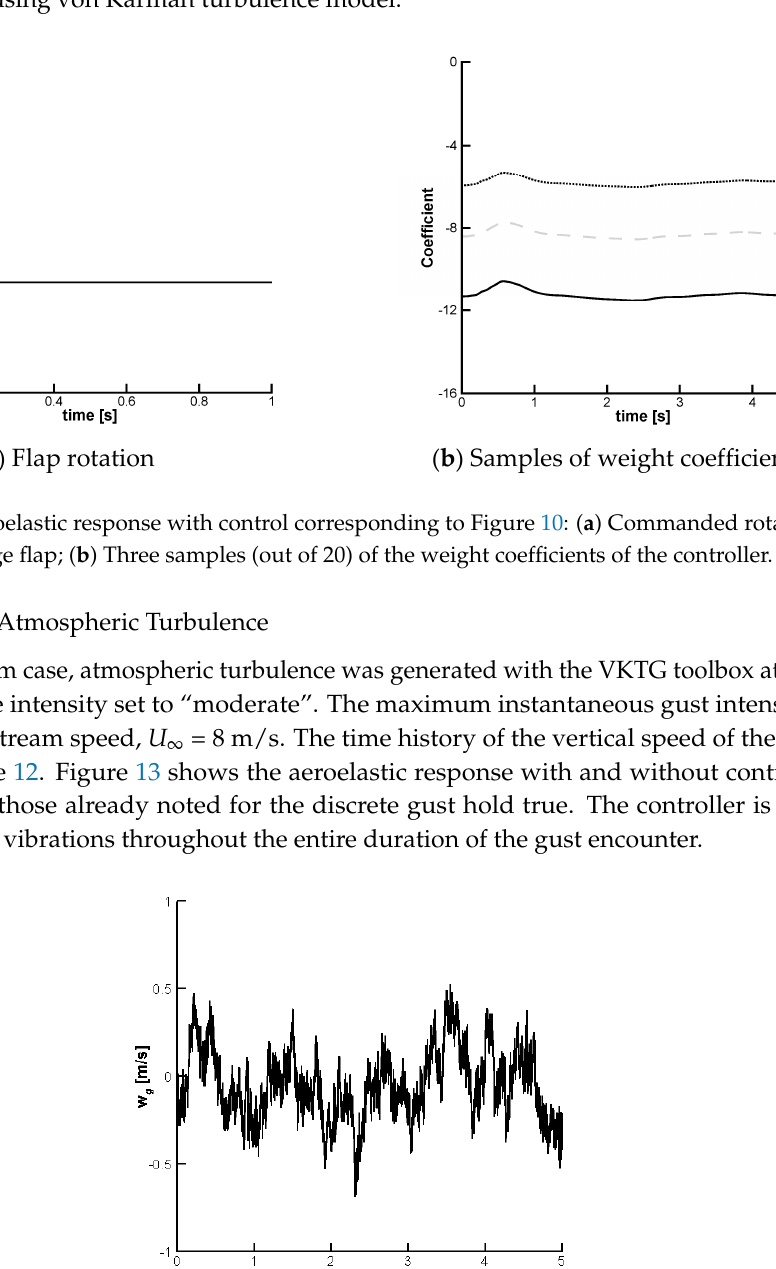
( b ) Plunge Figure 13. Aeroelastic response due to a random atmospheric turbulence (Figure 12) with and without control. To quantify the impact of the adaptive feedforward controller for GLA in the presence of atmospheric turbulence, the mean and standard deviation of the pitch and plunge time responses are listed in Table 3. When confronted with the uncontrolled aeroelastic response, the statistics of the pitch rotation are significantly improved by the control action: the mean value is reduced by approximately 80% and the standard deviation by approximately 35%. The increase in the statistics of the plunge is not unexpected, as it was assumed unmeasurable for the purpose of GLA. The trade- off between the reduction in pitch statistics and the increase in plunge statistics is yet in favor of the former. For the wing typical section, the pitch and plunge are structural modes. The input to the controller is a measure of the pitch degree of freedom, that is, one structural mode. Therefore, it is